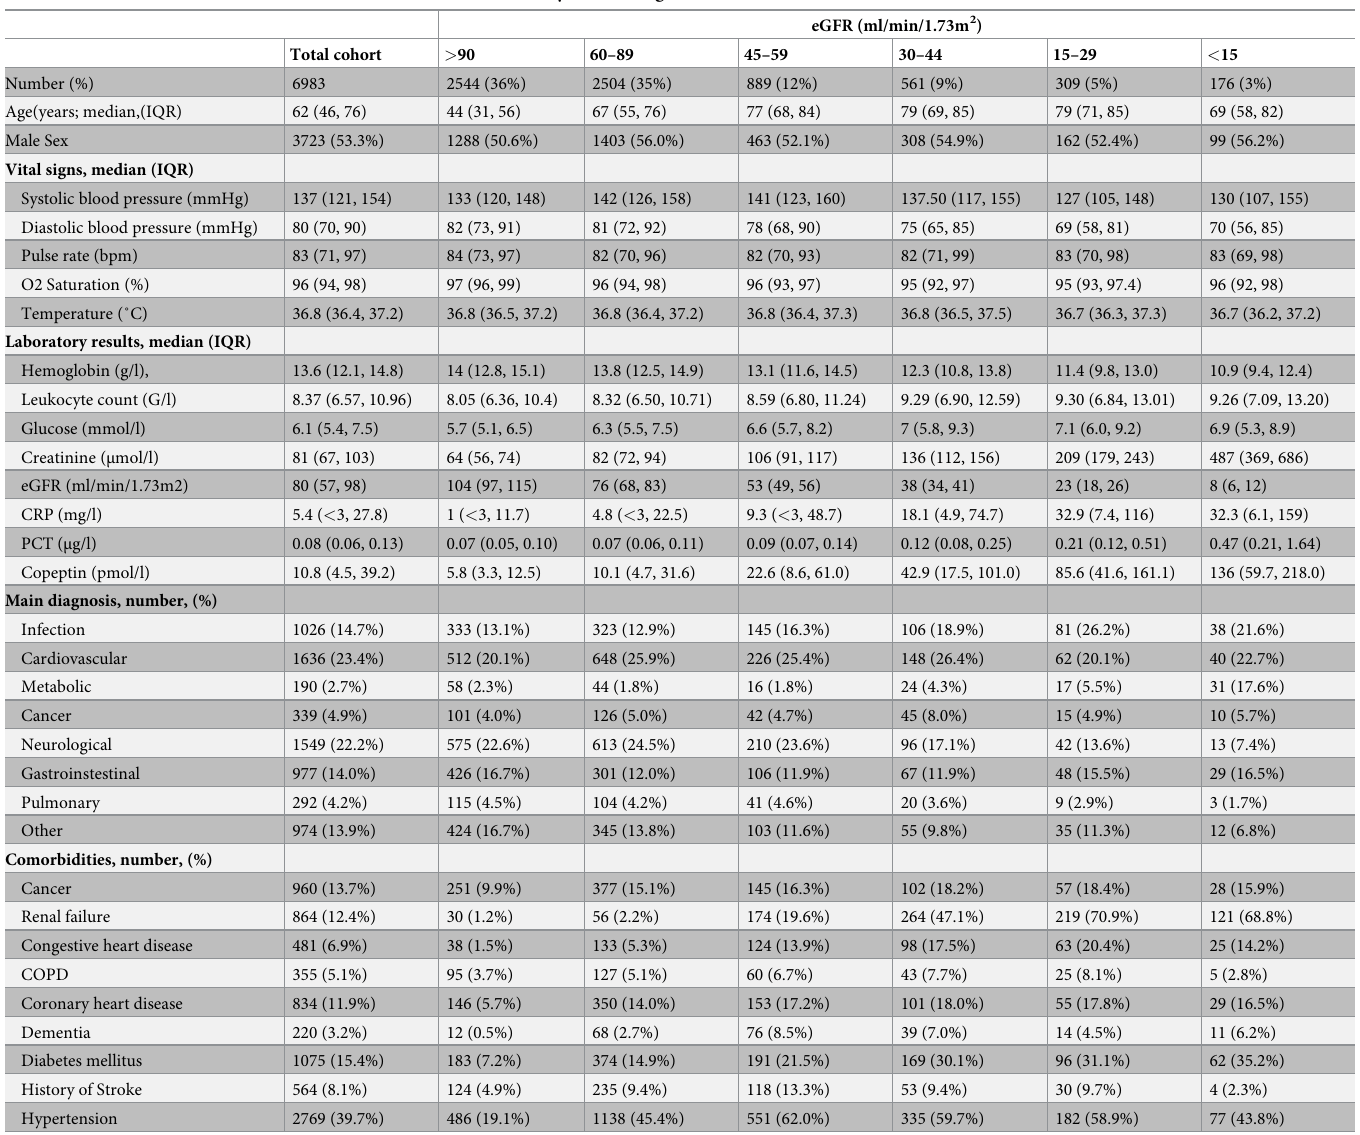
Table 1. Baseline characteristics of the total cohort and stratified by eGFR